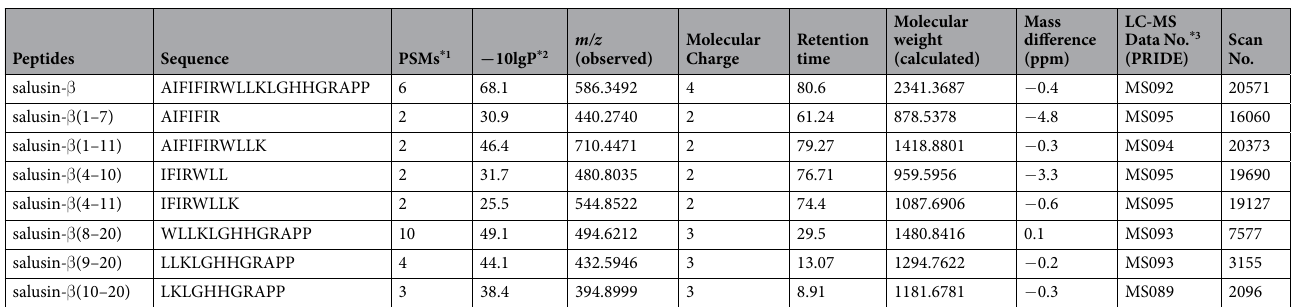
Table 1. Salusin- β and its seven endogenous fragments detected in human plasma. * 1 PSMs, Peptide signal matches. * 2 False discovery ratio thresholds of 1%, 0.1%, 0% estimated with the target-decoy method 45 are the values of − 10lgP of 21.0, 26.9, 31.9, respectively. * 3 Number of LC-MS raw data deposited in ProteomeEXchange Consortium 32 with the identifier PXD003533.